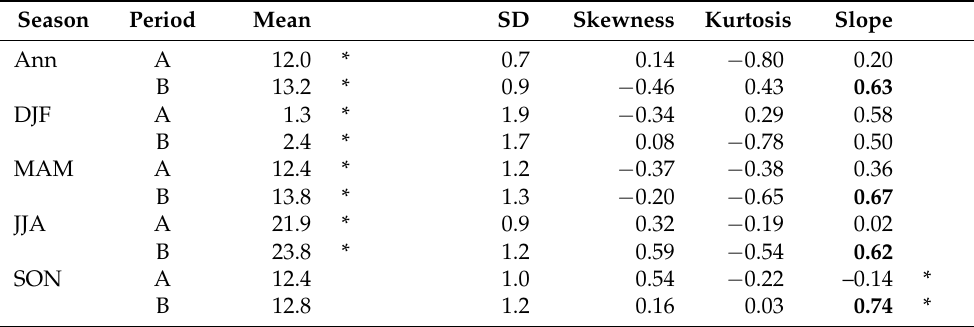
Table 4. Selected statistical characteristics of annual (Ann) and seasonal (DJF, MAM, JJA, and SON) mean maximum temperature series in the Czech Republic in the 1961–1990 (A) and 1991–2020 (B) periods: means and standard deviations (SD) are in ◦ C, linear trends in ◦ C/10 years (in bold statistically significant at the 0.05 significance level). An asterisk * indicates statistically significant differences of a given characteristic between two 30-year periods.